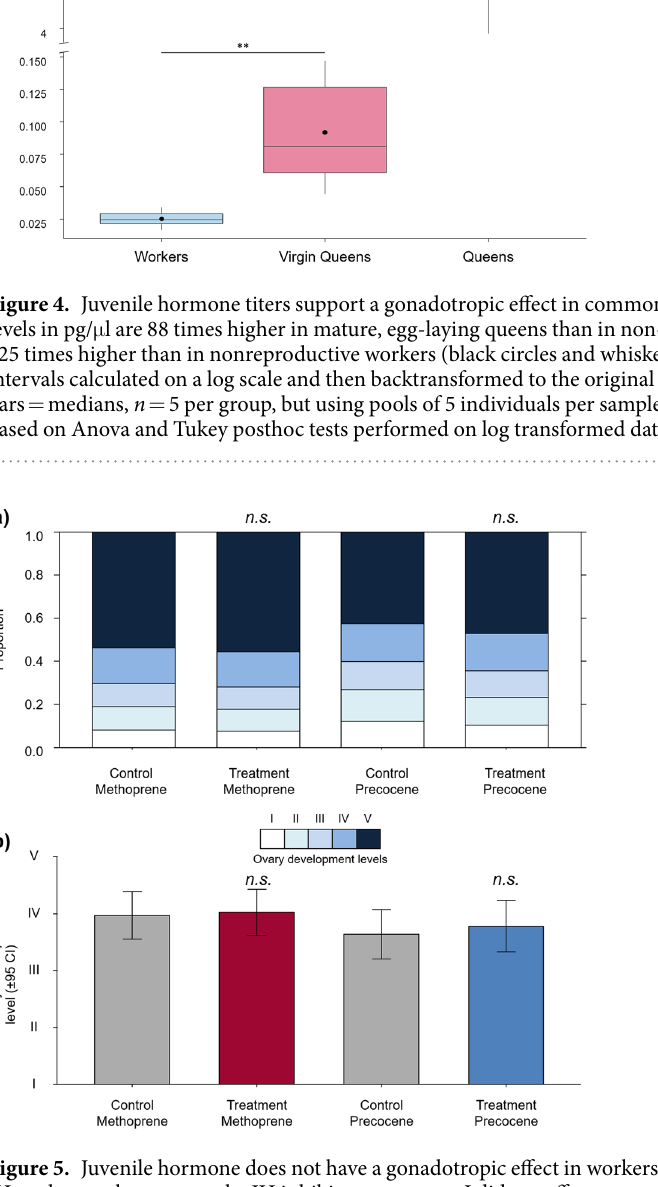
of worker ovary development (Fig. 5), despite the fact that a high proportion of workers (42.5%) developed their ovaries across all treatment groups during the experimental period (Fig. 5). This was shown from the fact that when the workers’ ovary development was scored on a 5-point scale (see methods), no quantitative differences in worker ovary development were observed either among the methoprene or precocene-treated groups and their respective controls (ordinal logistic model with Tukey posthoc correction, methoprene: z ratio = − 0.181, p = 0.998; precocene: z ratio = − 0.447, p = 0.970) or between the two treatments ( z ratio = 0.785, p = 0.861).